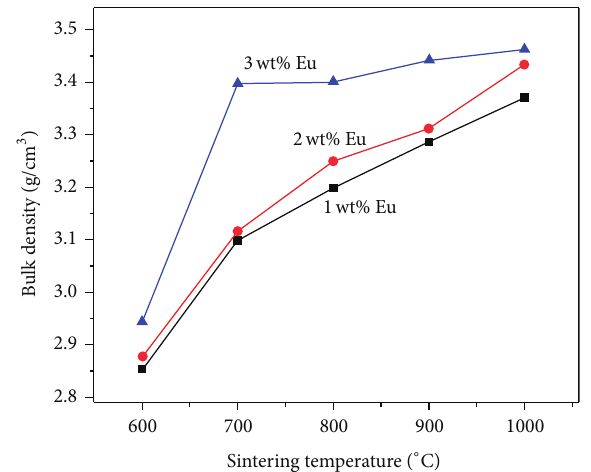
Figure 1: Bulk density of Eu 2 O 3 doped willemite-based glass ceramic as a function of sintering